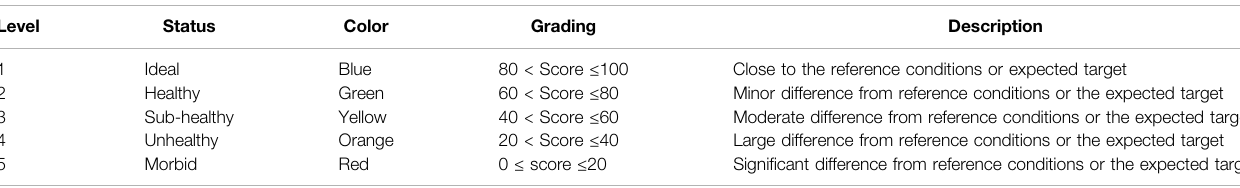
TABLE 2 | River health levels and grading